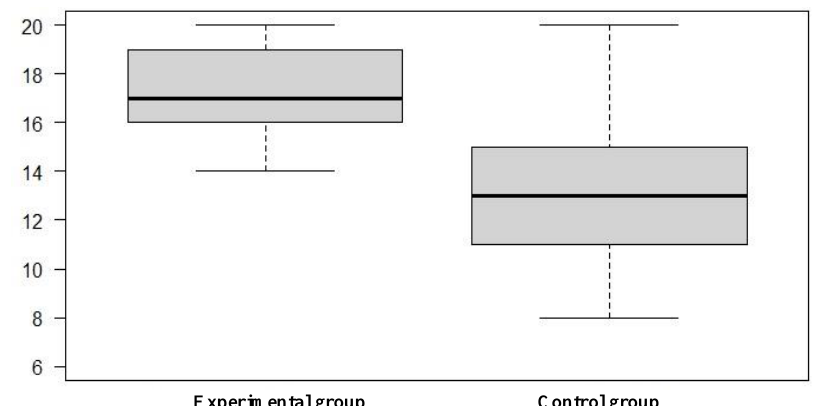
Figure 5. Hypothesis 3 – Cognition (boxplot)